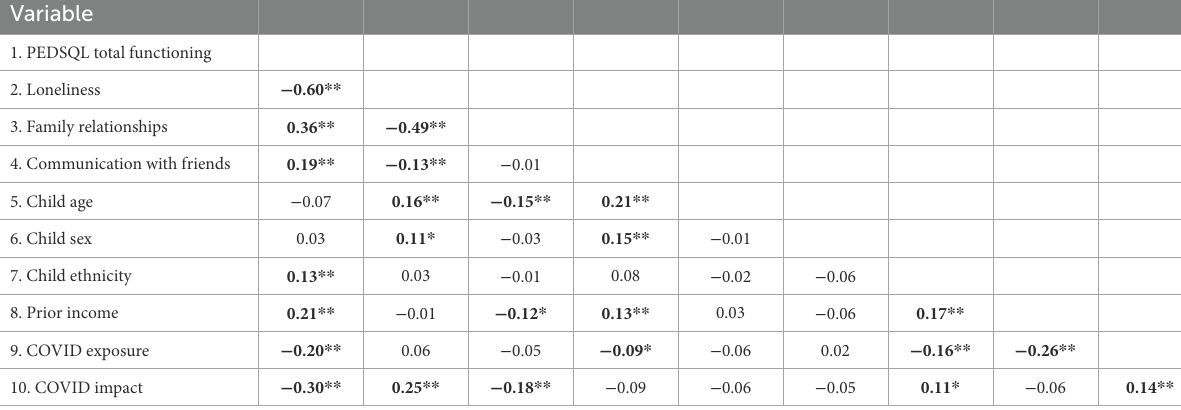
TABLE 4 Correlations between demographic characteristics and child report of quality of life and loneliness.